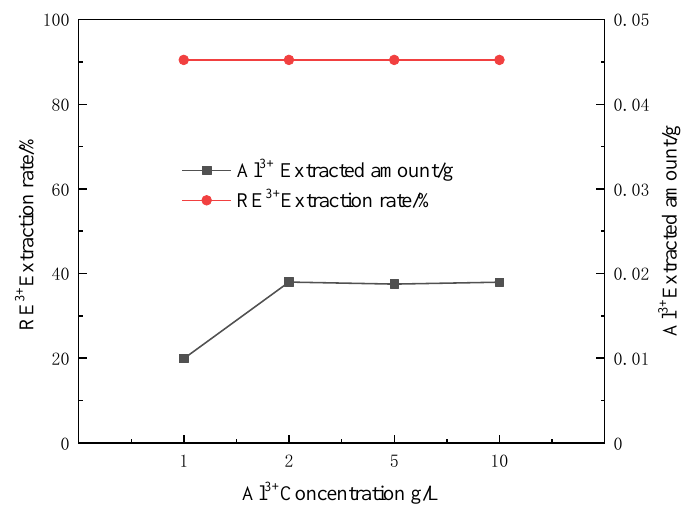
Figure 7. Effect of Al 3+ concentration on the separation of rare earths and aluminum.